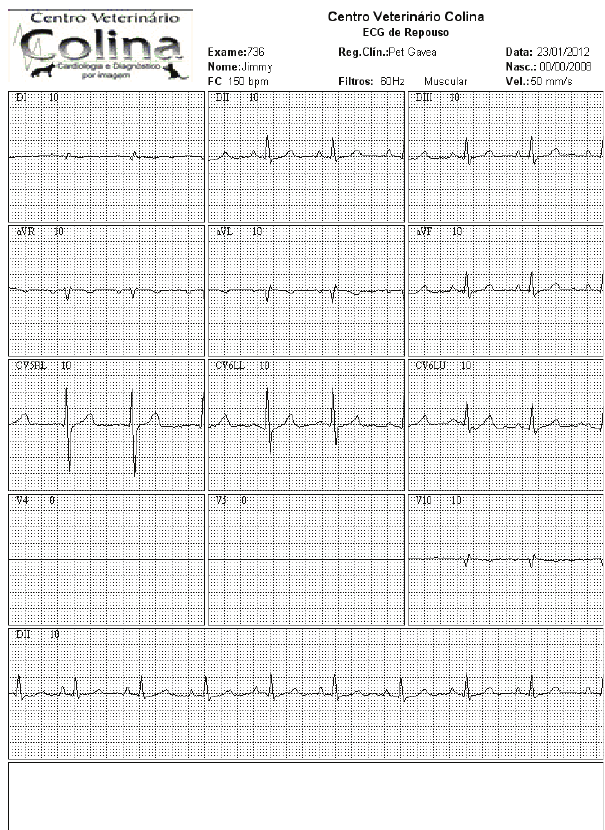
Figure 2: The ten-lead computed electrocardiographic tracing reveals sinus rhythm, main QRS axis falling between +80 and +90 degrees, heart rate of 150 beats per minute, and no criteria for chamber enlargement. Calibration: 1cm = 1mv and velocity of 50mm per second.